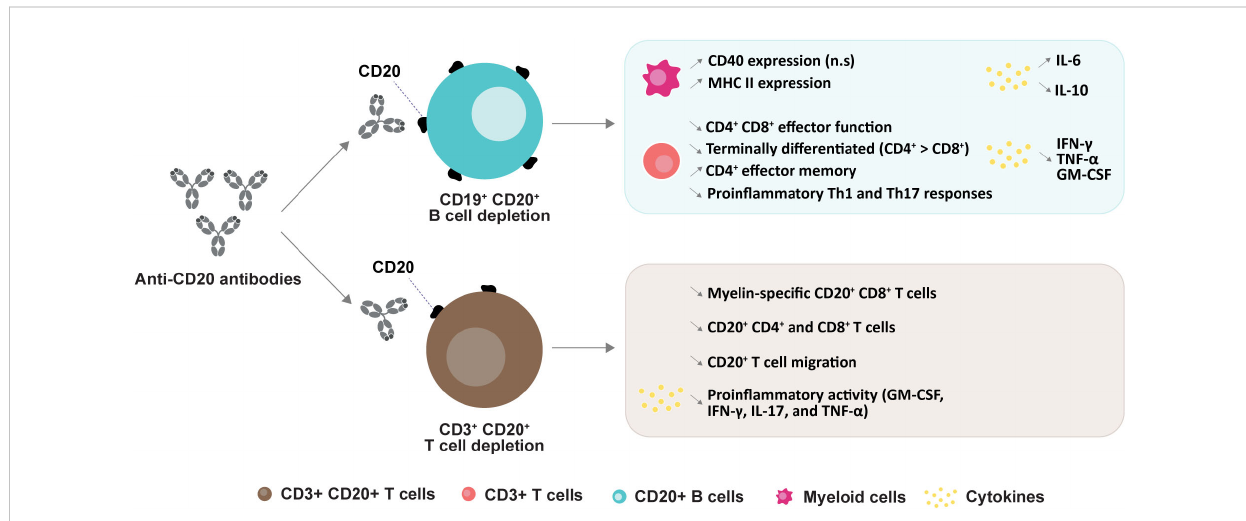
FIGURE 3 Anti-CD20 mediated changes in subtypes and their functions. CD20+ B cell depletion leads to an increase in CD40 expression (n.s: non-signi fi cant) and MHC II expression in myeloid cells (79); a decrease in CD4+ and CD8+ effector function (79), proin fl ammatory Th1 and Th17 responses (82), and numbers of terminally differentiated T cells, and an increase in CD4+ effector memory cells (85). Secretion of cytokines are changed upon B cell deletion (79, 85). CD20+ T cell depletion induces a decrease in myelin-speci fi c CD20+ CD8+ cells (84), in both CD20+ CD4+ and CD8+ cells (86), in CD20+ T cell migration (85) and a decrease in pro-in fl ammatory cytokines (49,